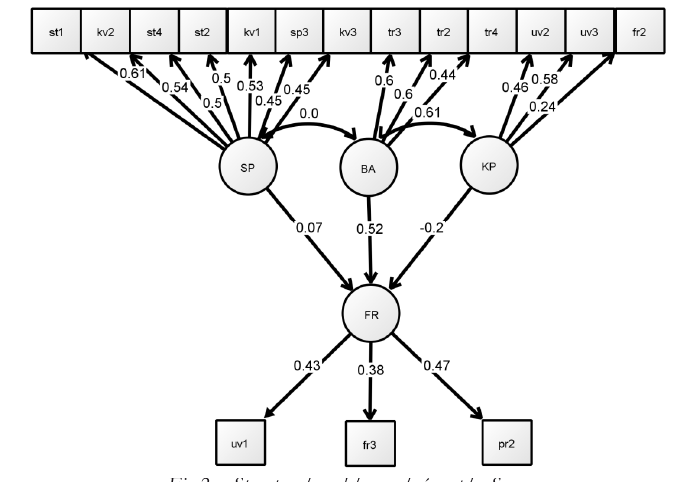
Fig 2 – Structural model – males´sample. Source: